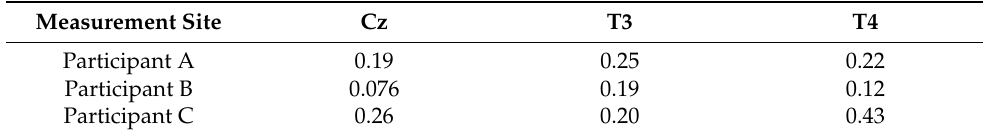
Table 5. Ratio of lost